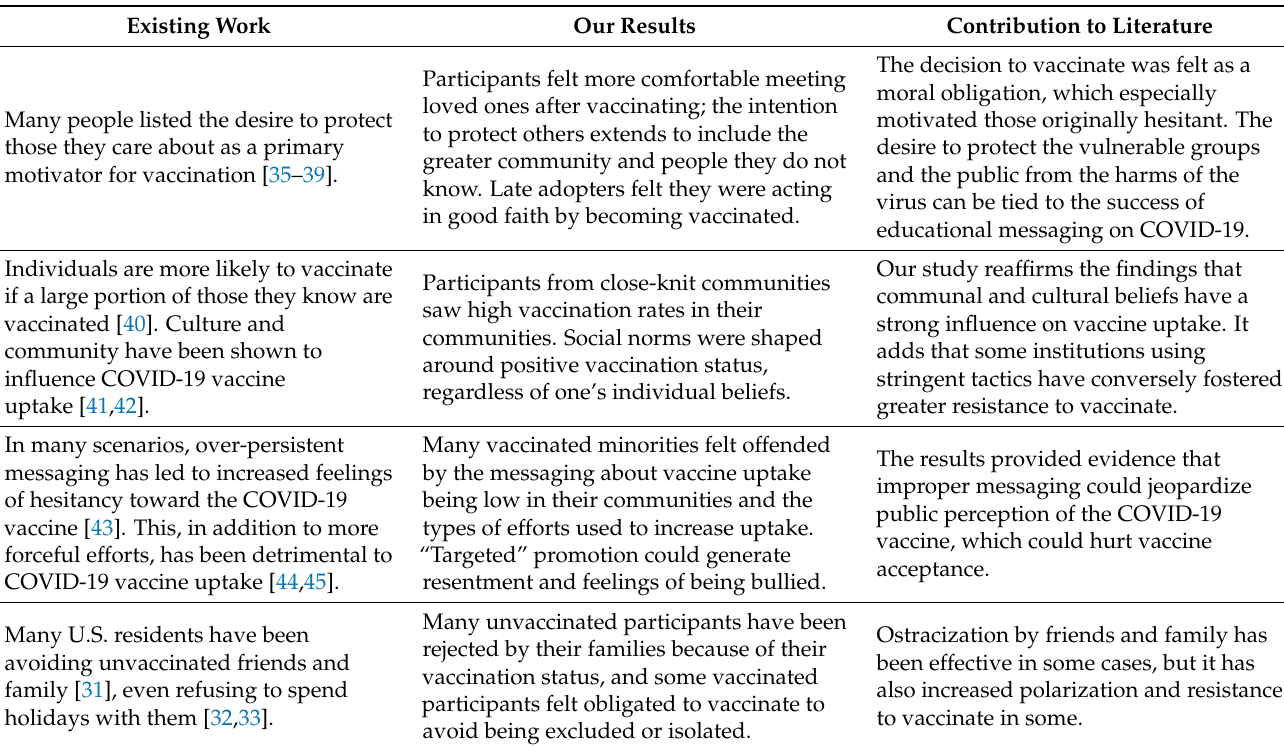
Table 1. Summary of the current study contribution compared to existing research on social norms and